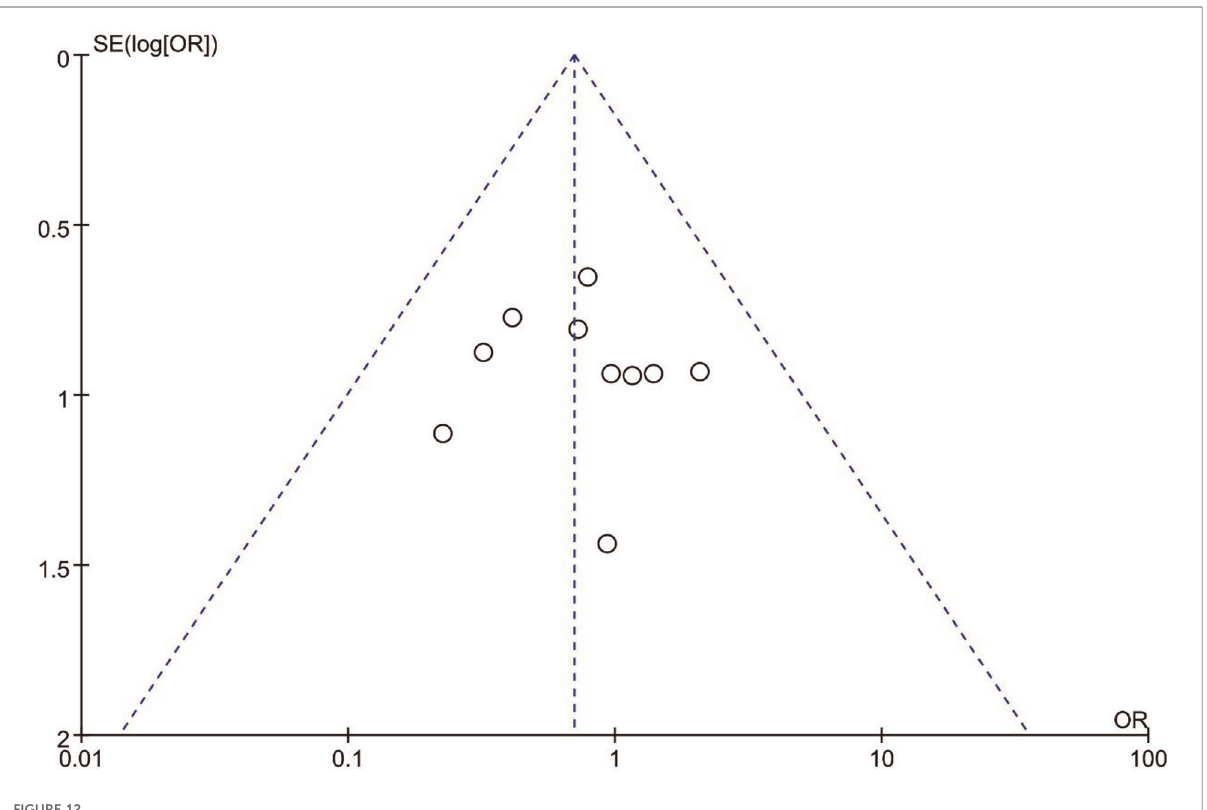
FIGURE 12 Publication bias of complications UBE vs MED.